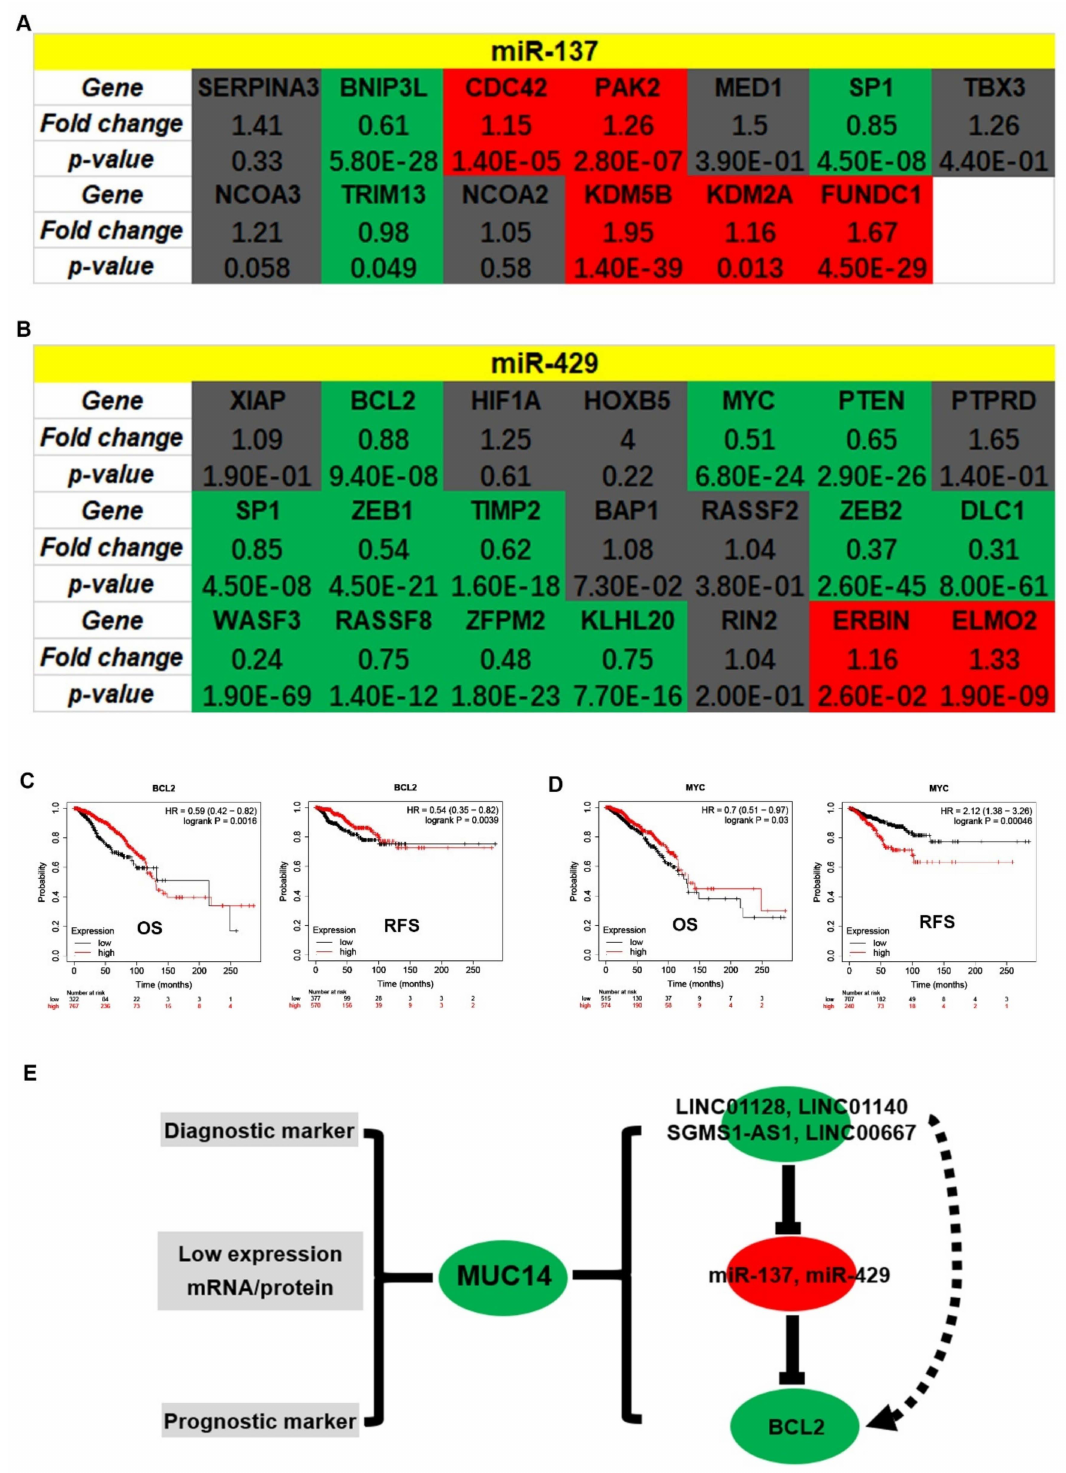
Figure 9. Identification of potential downstream targets of MUC14-miR-137/miR-429 axis in breast cancer. ( A ) The expression landscape of target genes of miR-137 ( A ) and miR-429 ( B ) in breast cancer. Red: high expression; green: low expression; grey: no statistical difference. The prognostic values of BCL2 ( C ) and MYC ( D ) in breast cancer. ( E ) The mechanism graph of the MUC14-related ncRNA-mRNA axis in breast cancer. “ p < 0.05” was considered as statistically